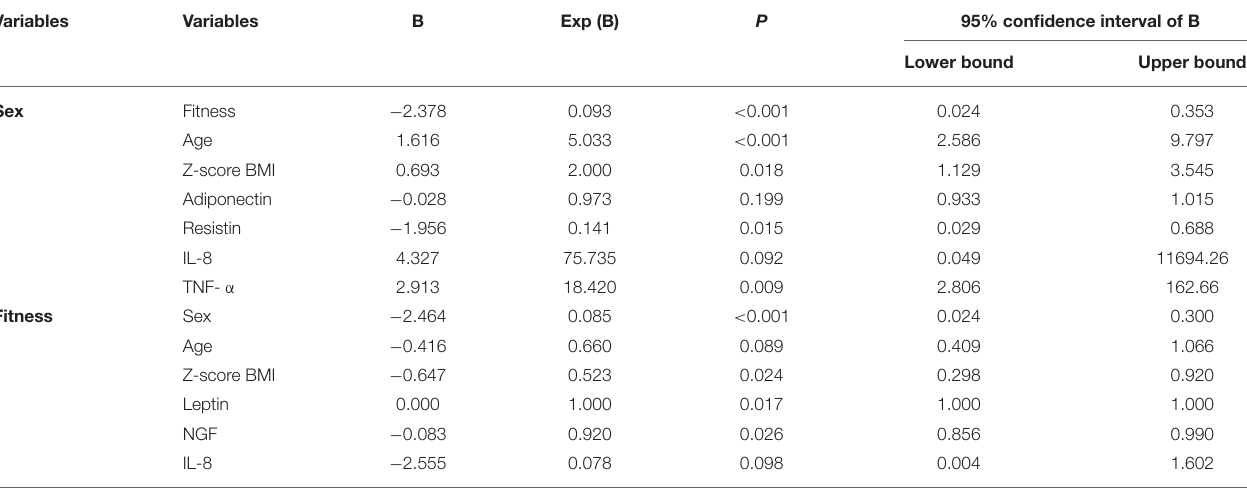
TABLE 5 | Logistic regression analysis for sex and fitness with different anthropometric variables and plams cytokines.